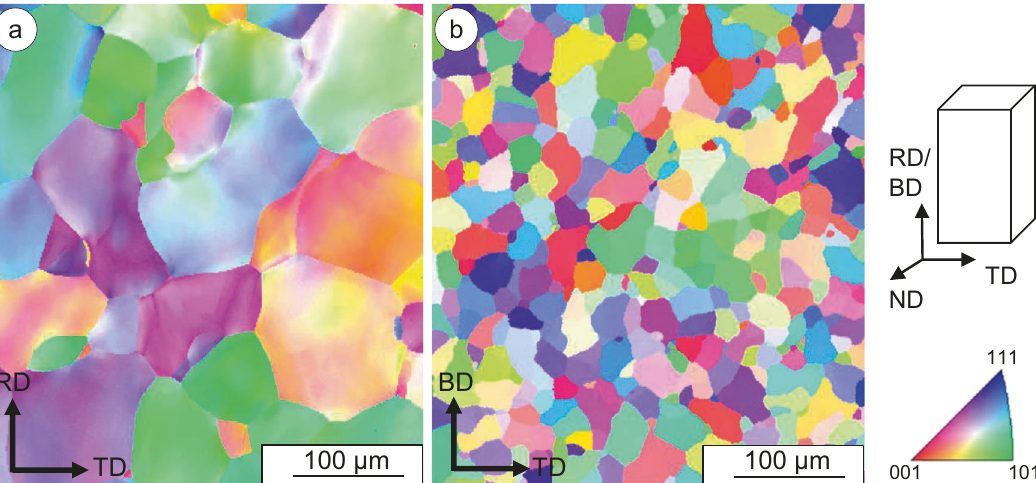
Fig. 2 EBSD orientation mappings with indication in normal direction (ND). a HR iron, b EBM iron. The rolling direction (RD), the building direction (BD) and transverse direction (TD) are marked in the fi